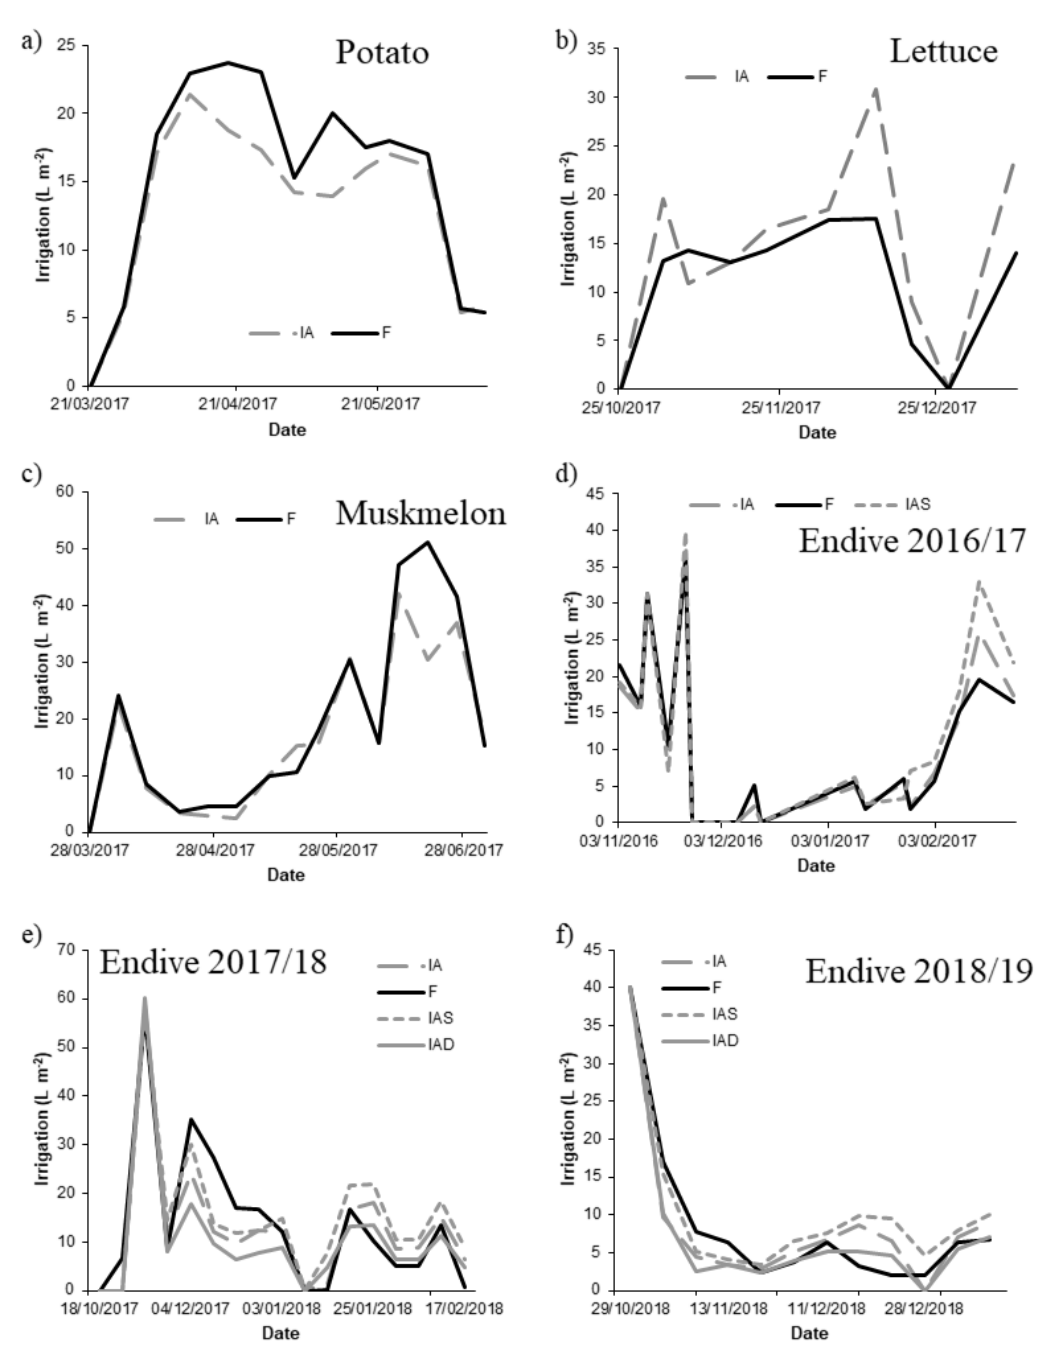
Figure 3. Irrigation patterns in each treatment over the growing seasons for the six crop cycles studied. F = Irrigation according to farmer ′ s practices; IA = irrigation according to Irrigation ‐ Advisor recommendations; IAS = irrigation according to Irrigation ‐ Advisor recommendations with a 25% surplus; IAD = irrigation according to Irrigation ‐ Advisor recommendations with a 25% deficit: (a) Potato; (b) Lettuce; (c) Muskmelon; (d) Endive 2016/17; (e) Endive 2017/18; (f) Endive 2018/19.